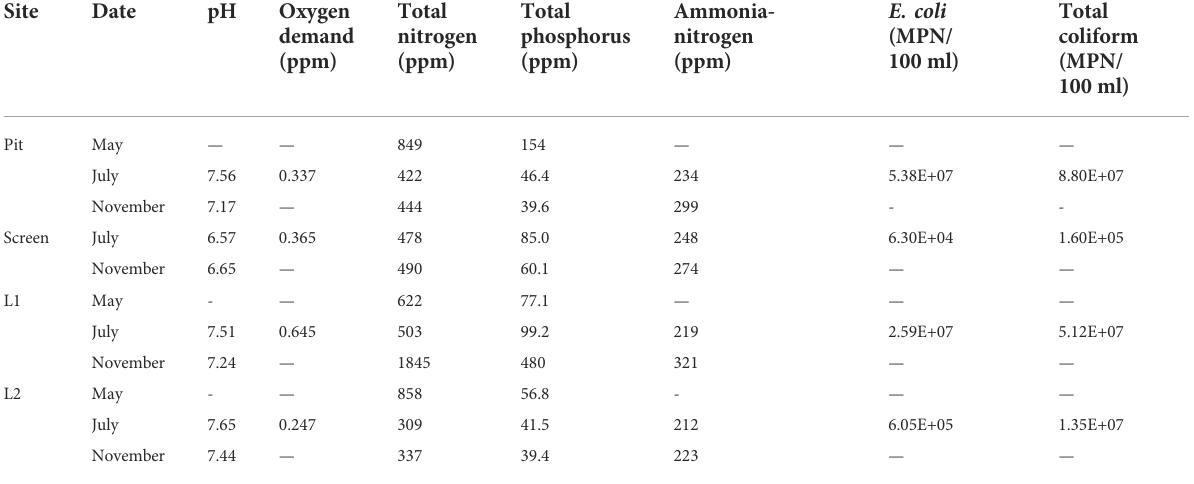
TABLE 1 Water quality from the wastewater treatment